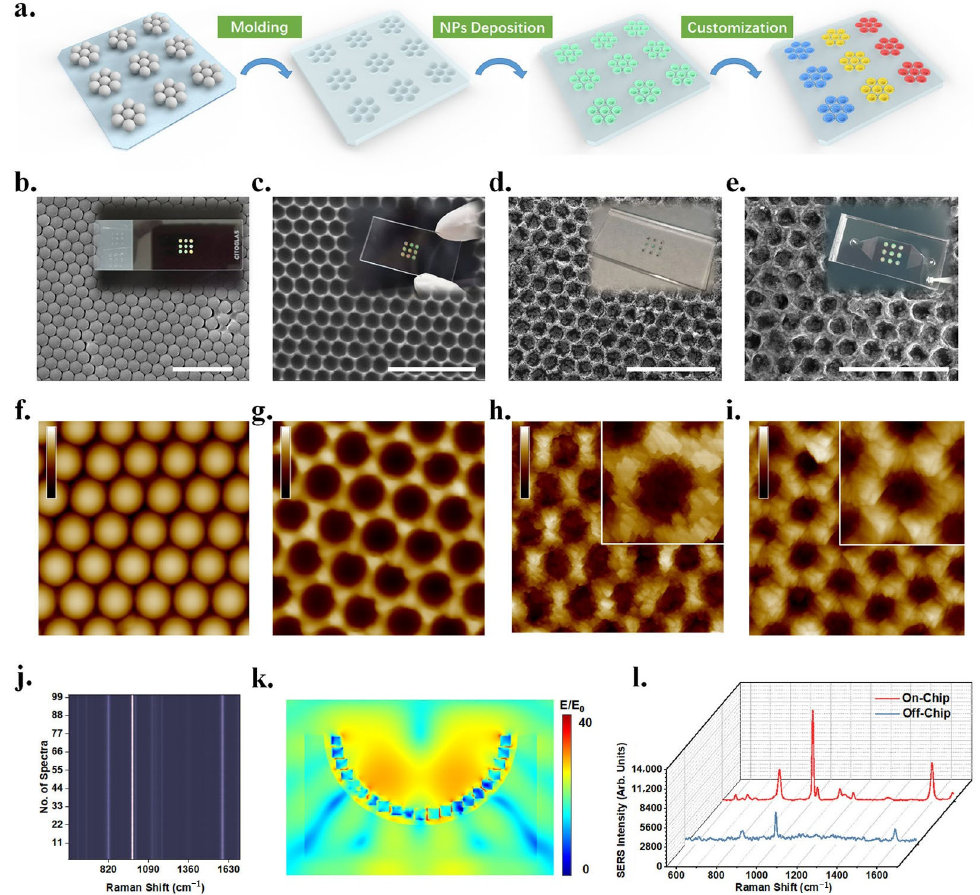
Figure 9. Construction and characterization of the plasmonic gas sensor with three different detection units. ( a ) Schematic diagram of fabricating the gas sensor. ( b ) SEM image of PS mold. ( c ) SEM image of PDMS substrate with nanopores. ( d ) SEM image of PDMS-substrate-deposited nanocubes. ( e ) SEM image of the substrate after deposition of Ti 3 C 2 T x MXene. ( f – i ) AFM images corresponding to ( b – e ) diagram. ( j ) The stack image of SERS spectra of benzaldehyde at random regions. ( k ) Numerical simulation of the electromagnetic field in a single dent deposited bimetallic nanocubes. ( l ) SERS spectra of benzaldehyde obtained on the sensor and off the sensor. Reproduced with permission from reference [79]. Copyright 2022 American Chemical Society.